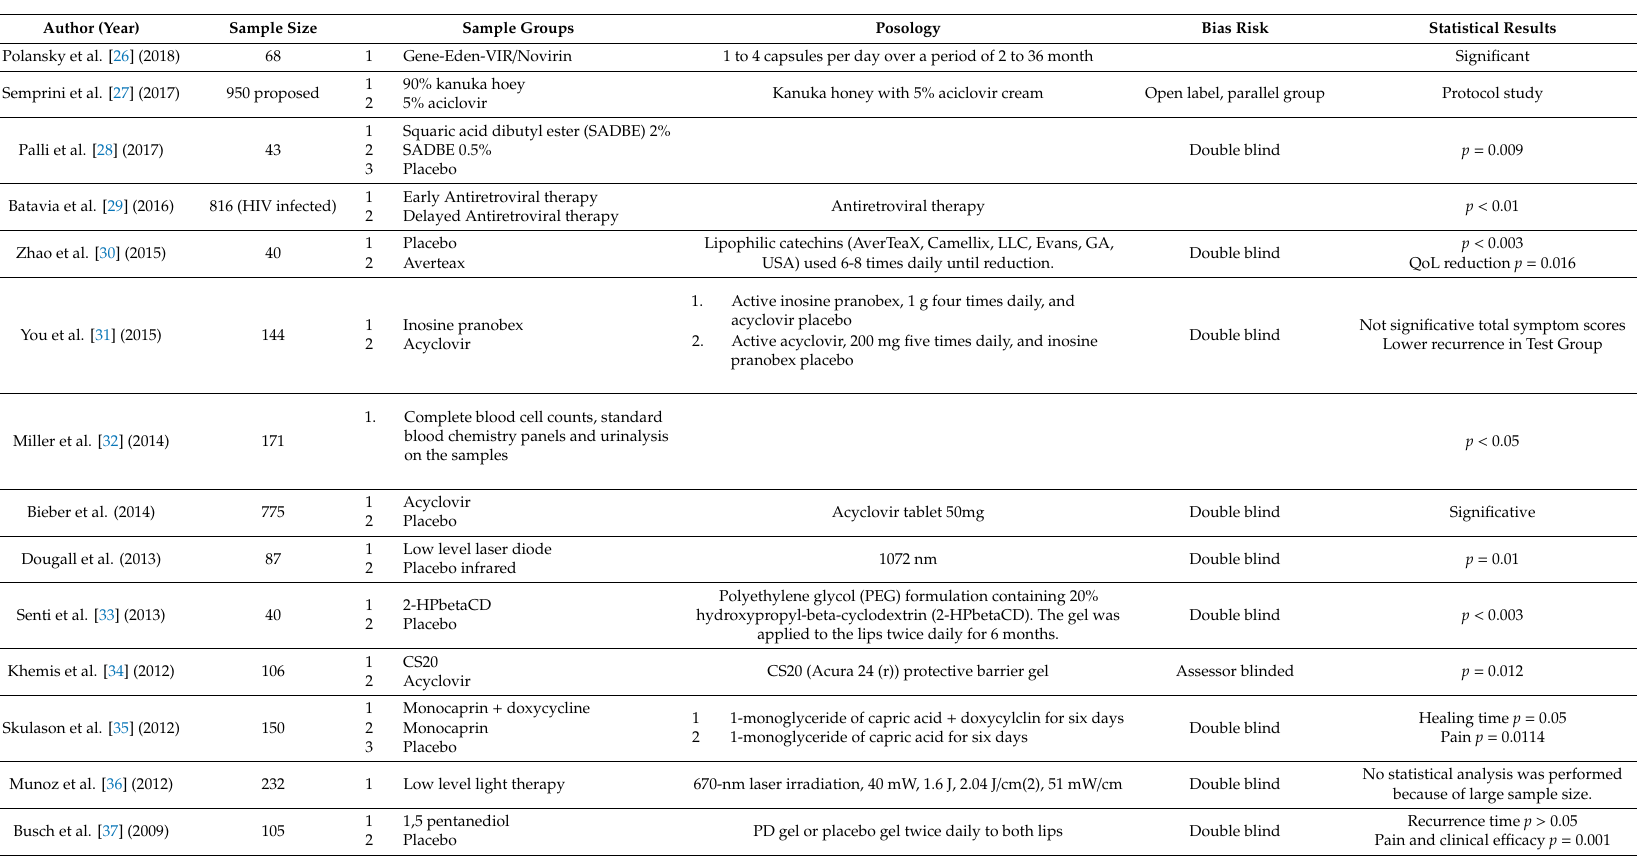
Table 2. Randomized clinical trials (RCTs) table with sample groups description and statistical